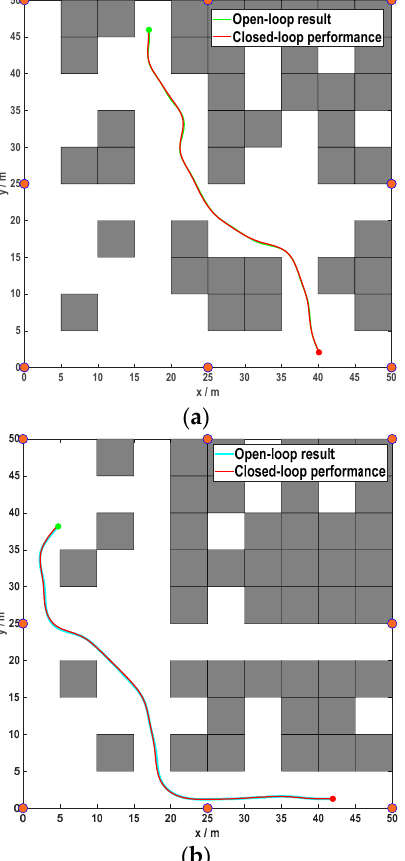
Figure 12. Path planning results, w.r.t. tractability: ( a ) Case 1; ( b ) Case 2.